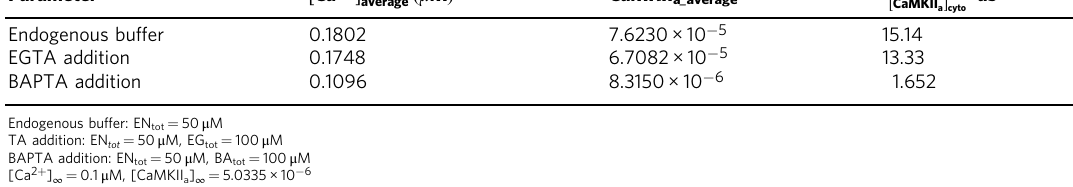
Table 2 Integration results of endogenous buffer, EGTA addition, and BAPTA addition